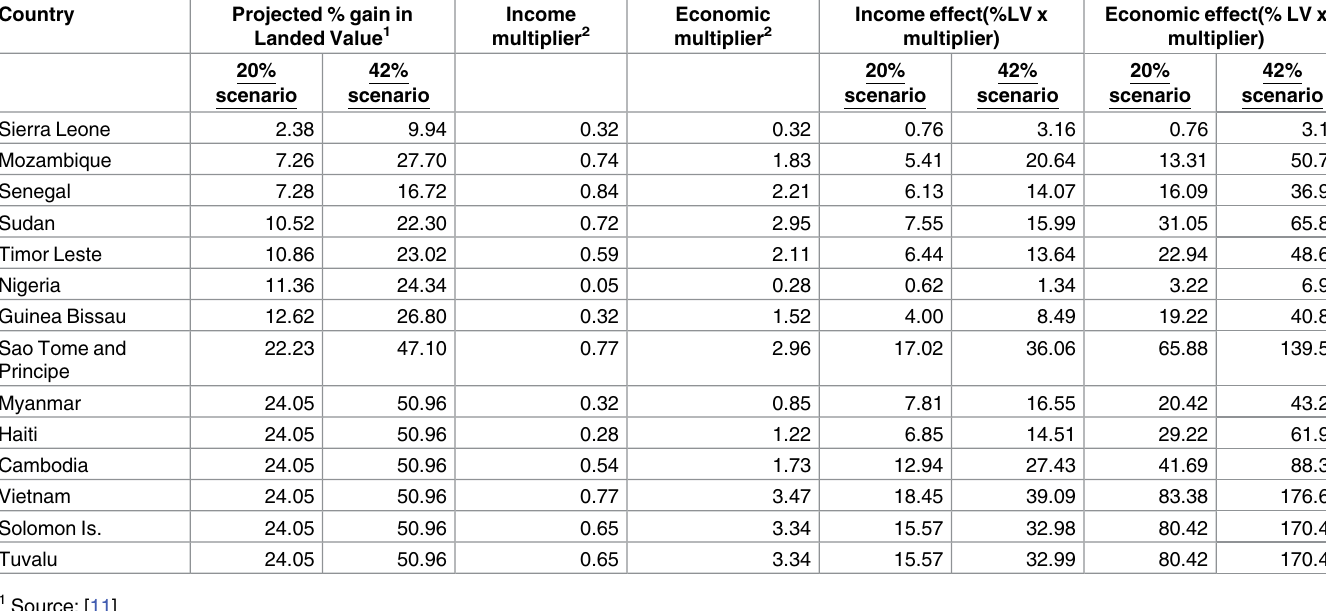
Table 4. Estimated economic and household income effectsarising from projected gains in landed